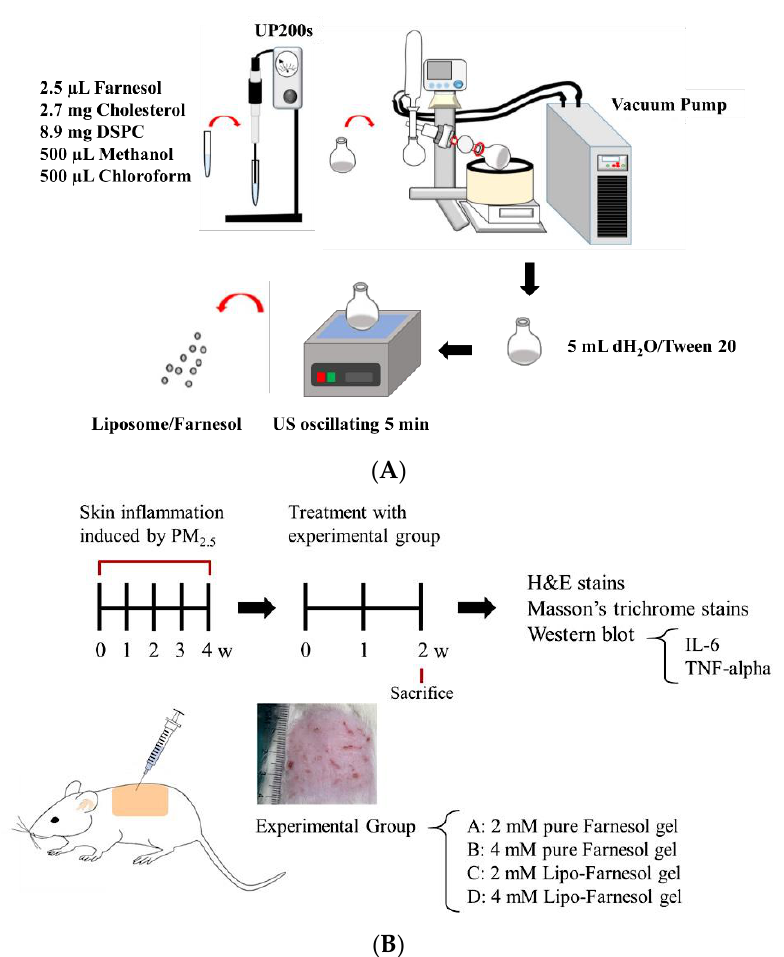
Figure 7. ( A ) Schematic of the process of liposome encapsulation of farnesol (Farn). ( B ) Timescale of post-PM 2.5 subcutaneous injective treatment with pure Farn or liposome-encapsulated Farn (Lipo-Farn; Category 1) and the continuous subcutaneous injection of PM 2.5 coupled with simultaneous Farn or Lipo-Farn treatment (Category 2). PM 2.5 : particulate matter with aerodynamic diameter ≤2.5 μm.